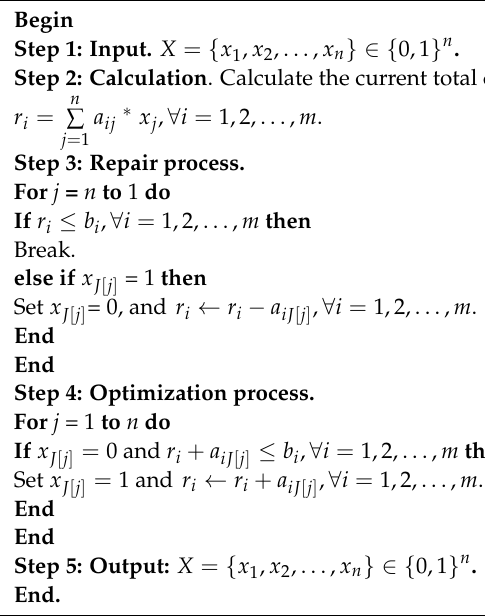
Algorithm 3. The quick repair operator base on the scaled